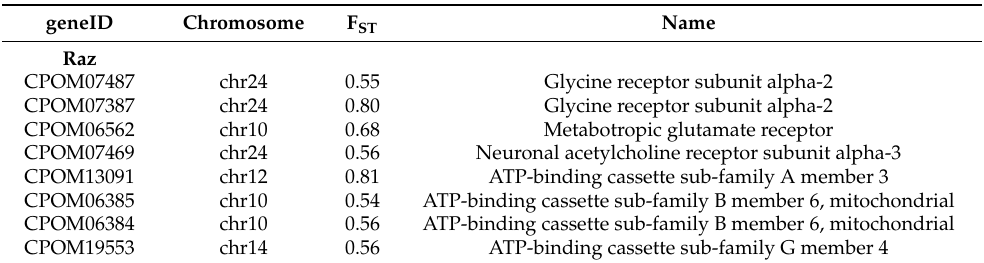
Table 2. F ST values of 21 resistance-related PSGs detected in the Raz and Rde strains of C. pomonella ,